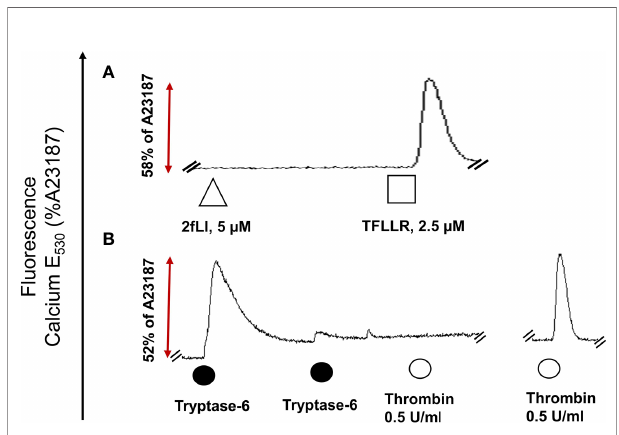
FIGURE 7 | Tryptase-6 triggers calcium signals in PAR2 knockout HEK-293 cells. The calcium signaling assay [ fl uorescence emission at 530 nm, as a percentage of the signal generated by the calcium ionophore A23187 (%)] was used to determine whether tryptase-6 can trigger calcium signaling via PAR2-independent pathways. Tracing (A) : The absence of a response to the potent PAR2-selective agonist, 2fLI (open triangle) but presence of a response to the selective PAR1 peptide agonist, TFLLR-amide (open square) con fi rmed the absence of functional PAR2 and the presence of functional PAR1 in the HEK-293-PAR2-null cells. Tracing (B) : Volume equivalent to 5.8 FU/min/ng of PsA SF-derived tryptase-6 (solid circle) elicited a robust calcium response (dark circle), that was desensitized by the second consecutive exposure to tryptase-6 (second solid circle, Tracing B ). These tryptase-6- treated cells no longer responded to the PAR1 activator, thrombin (0.5 U/ml, open circle, fi rst tracing panel B ). Cells not treated with tryptase-6 showed a strong calcium signal caused by thrombin (right-hand tracing, panel B